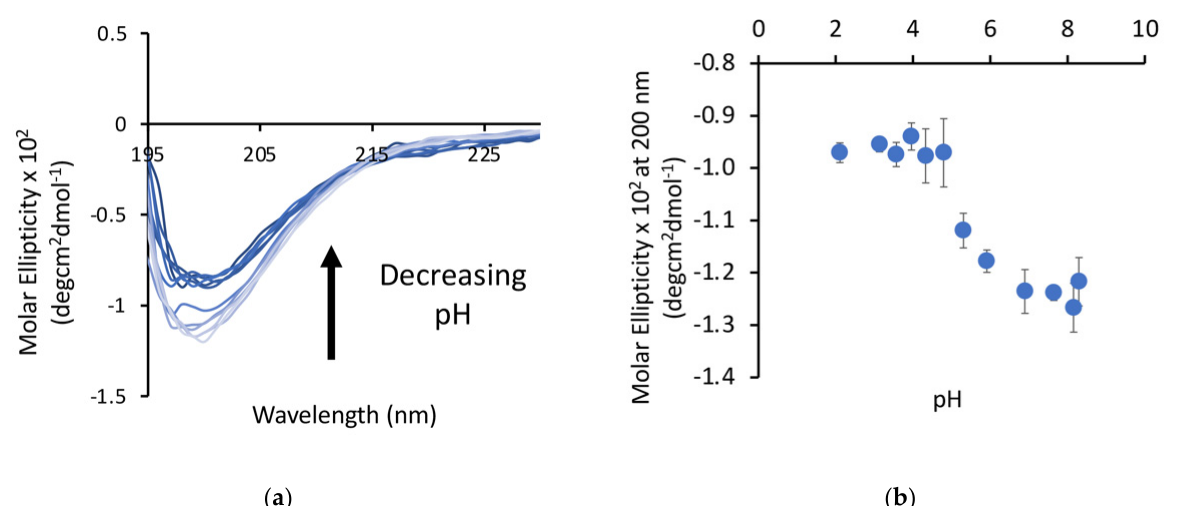
Figure 2. A peptide derived from the native poly-E sequence of titin shows a pH dependence as measured by CD. ( a ) CD spectrum of the poly-E peptide with an arrow indicating the direction of the change in the spectra with decreasing pH. ( b ) Molar ellipticity at 200 nm plotted against pH shows a transition to a more ordered state below pH 5.